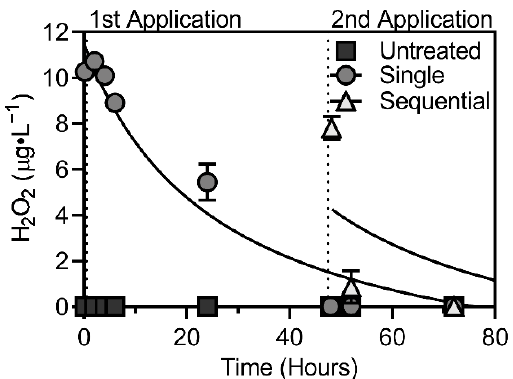
Figure 2. Average residual hydrogen peroxide (H 2 O 2 ) concentrations following exposures for un- treated (black squares), single application (dark gray circle), and sequential application (light gray triangles) mesocosms. A non-linear regression line was fit to show the overall trend in peroxide concentration. The dotted vertical line represents the first and second peroxide applications. Error bars represent +/ − the standard error of the mean (SEM), n = 4 per treatment.